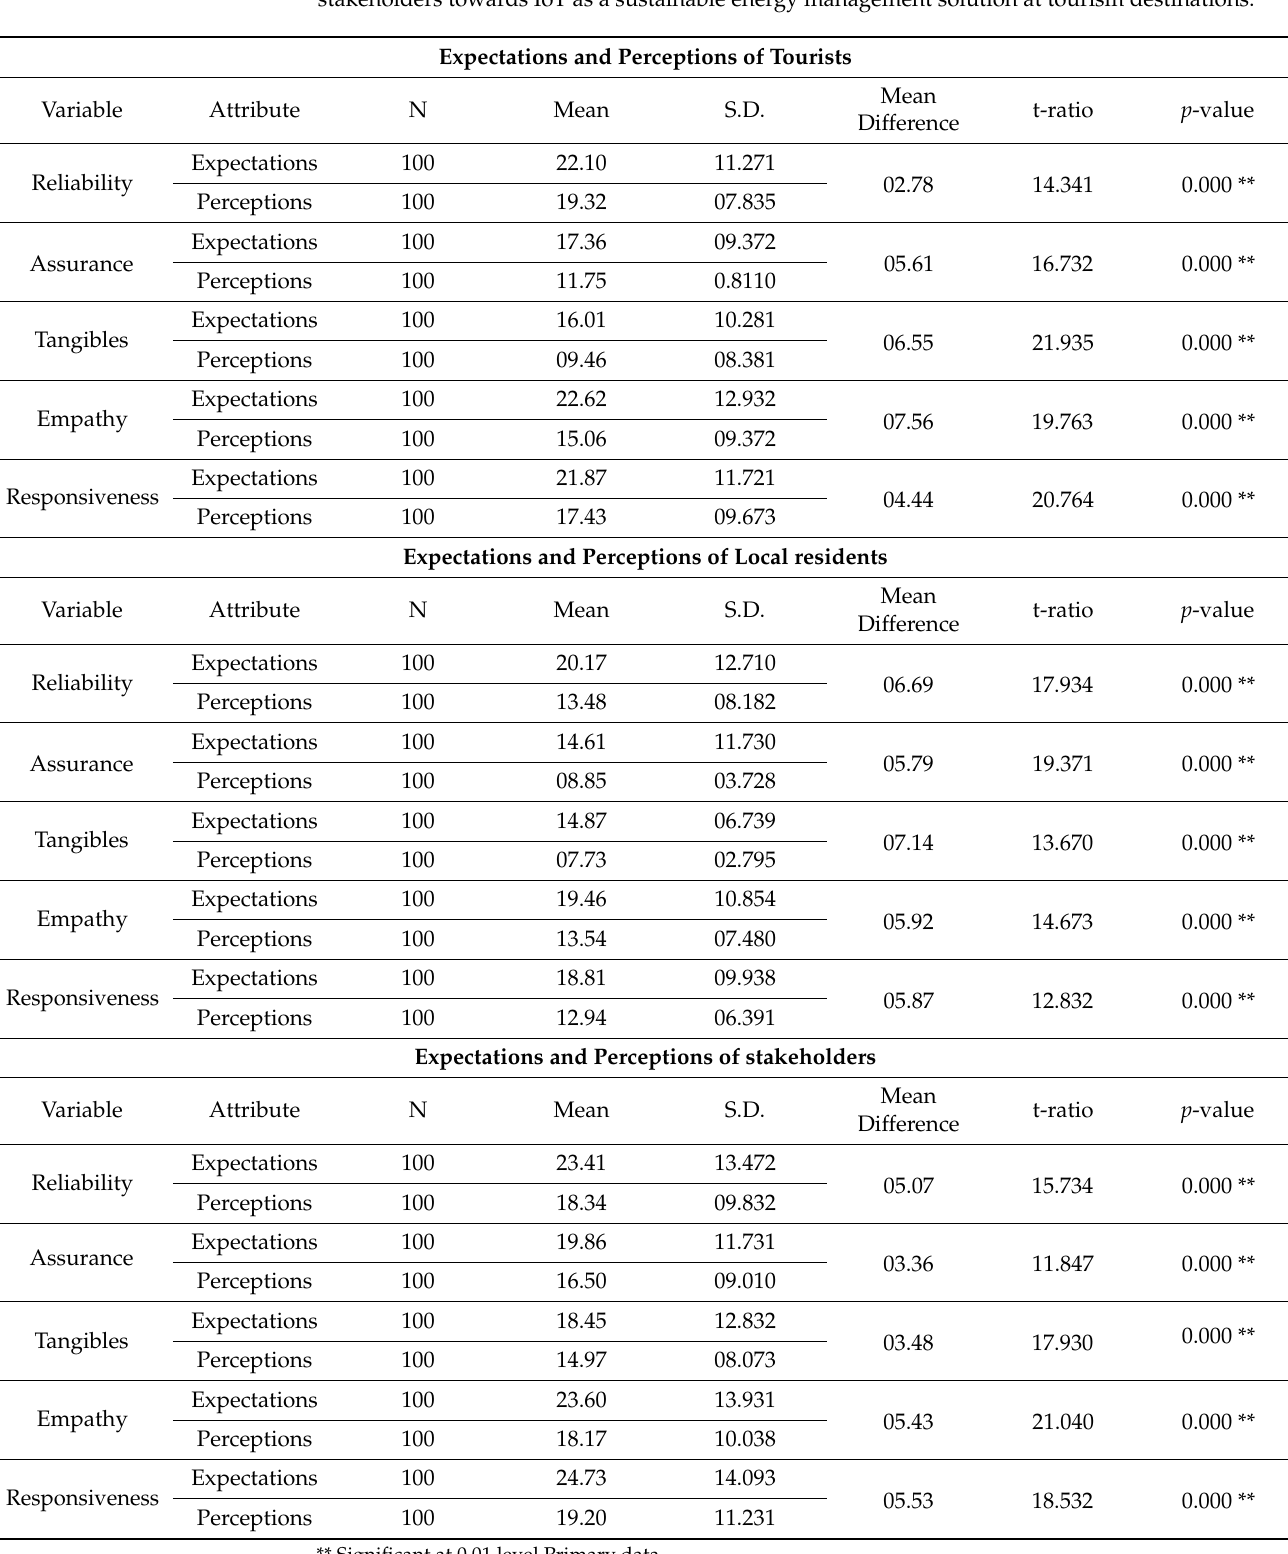
Table 2. Paired sample t -test results for expectations and perceptions of tourists, residents, and tourism stakeholders towards IoT as a sustainable energy management solution at tourism